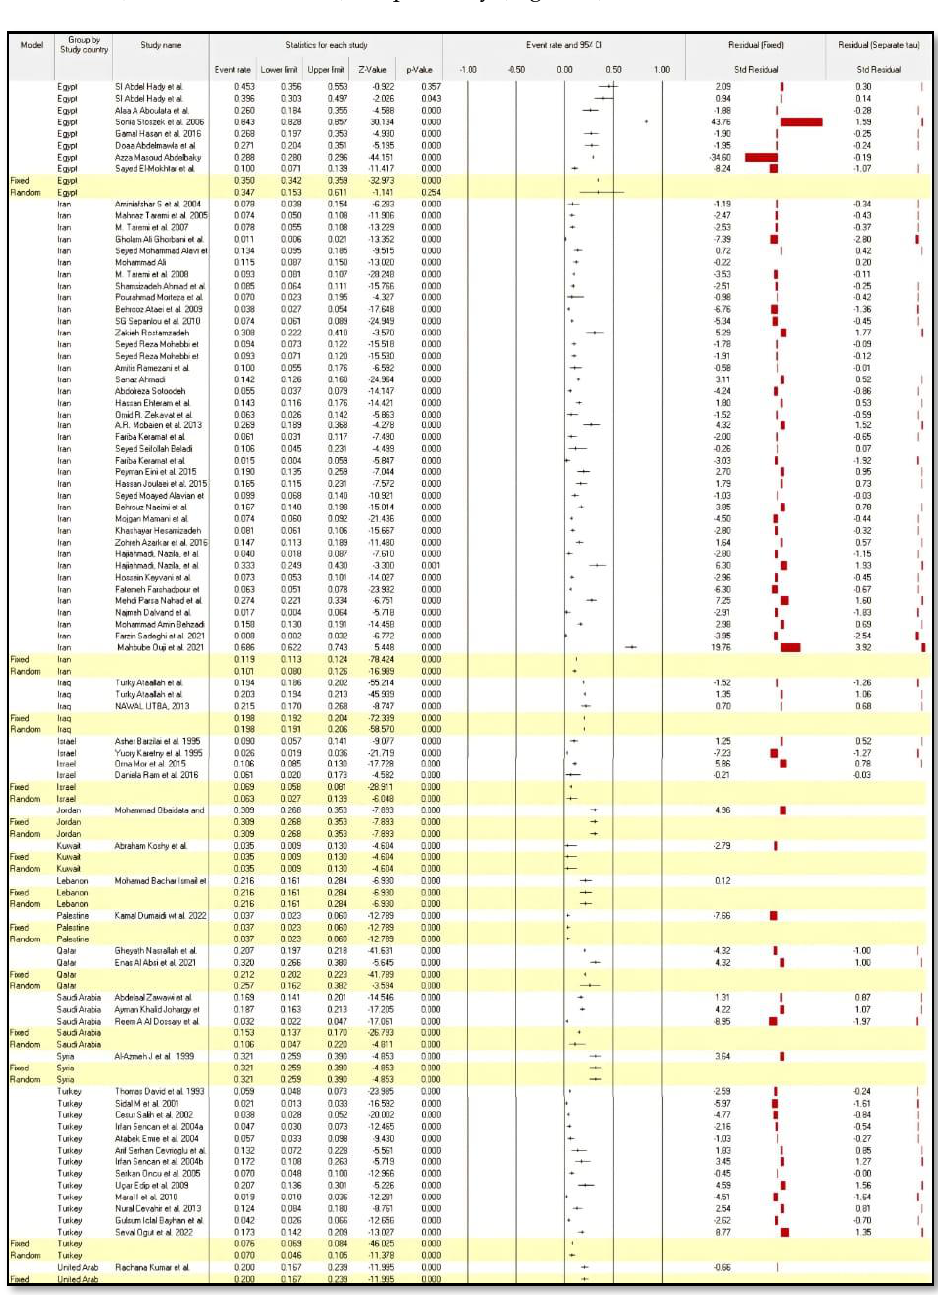
Figure 3. Forest plot meta-analysis of seroprevalence of hepatitis E virus infection by country [20–93]. The seroprevalence of HEV infection by the study population was highest in pregnant women 47.9% (95% CI: 0.459 – 0.499) in the fixed-effect model and in renal transplant recipients, 30.8% (95% CI: 0.222 – 0.410) in the random-effect model, as compared to other populations (Figure 4).